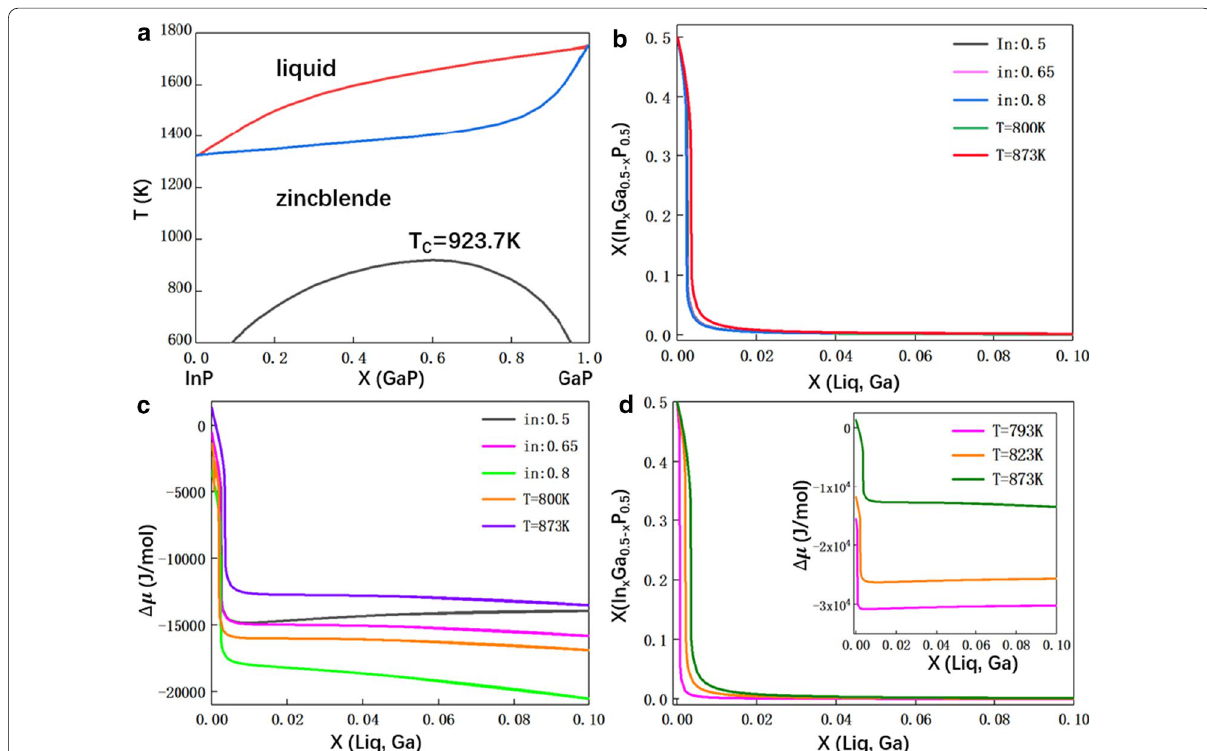
Fig. 5 Thermodynamic analysis of the nucleation process. a Pseudo-binary InP-GaP phase diagram. Calculated ( b ) In content in In x Ga 0.5- x P 0.5 and Gibbs energy change ( c ) as a function of Ga content in the Au droplet. d Composition and Gibbs energy analysis for InGaP nanowire formation under In-seeded